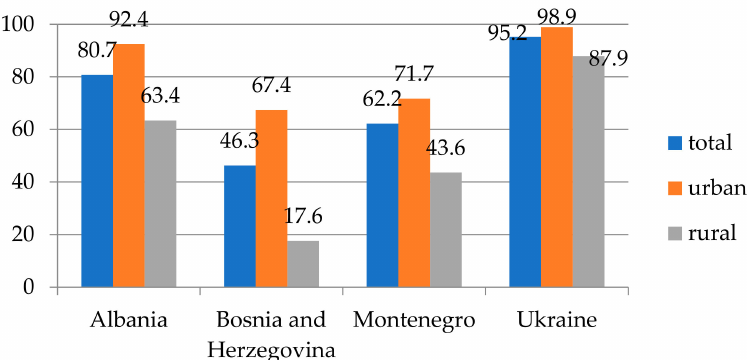
Figure 4. European countries with the lowest percentage of households using clean fuel for cooking in 2019 (total, urban, and rural areas). Source: own preparation based on Eurostat and World Bank database